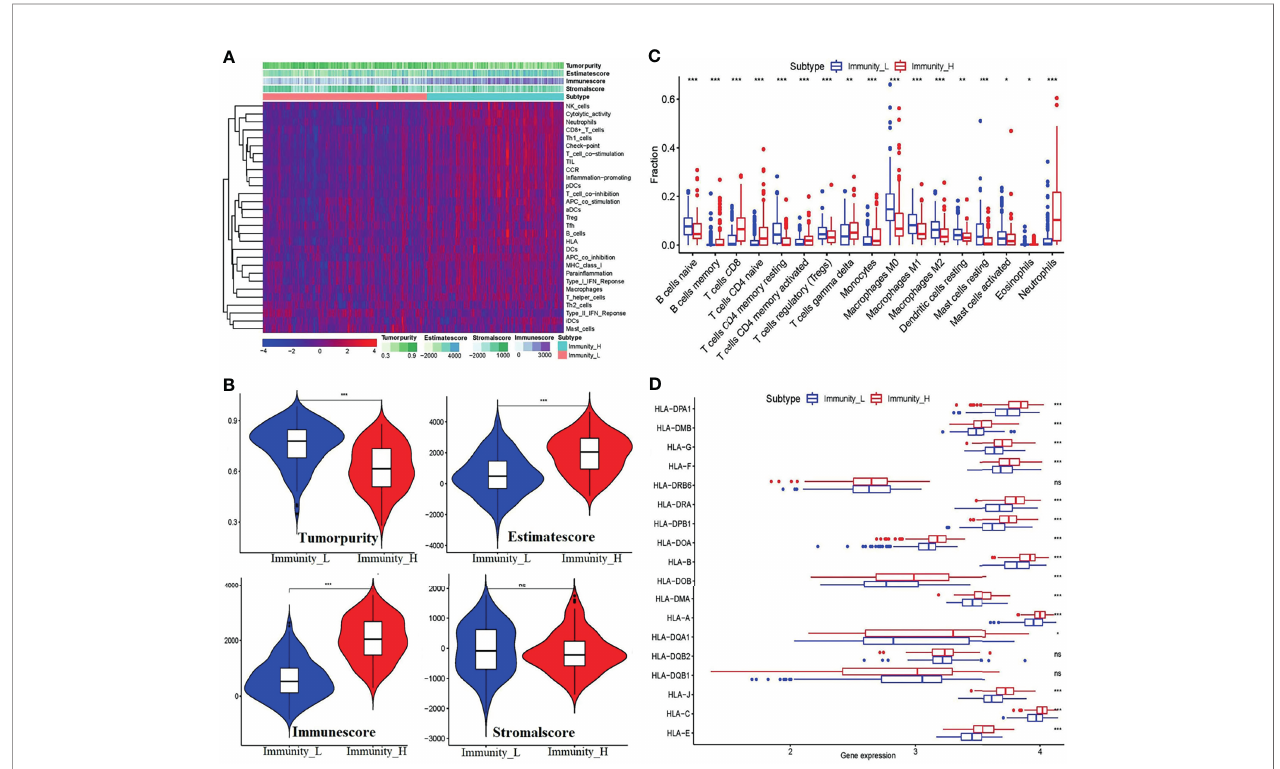
FIGURE 4 | Validation of the feasibility of the immune grouping strategy. (A) Heatmap of tumor purity, ESTIMATE score, immune score, and stromal score. (B) Violin plots showing the comparisons of the tumor purity, ESTIMATE score, immune score, and stromal score between the Immunity-L and Immunity-H subtypes. (C) The fraction of 17 kinds of immune cell in fi ltration scores between the two groupings. (D) Boxplot of HLA gene expression between the two groups. *p < 0.05, **p < 0.01, ***p < 0.001, ns, no signi fi cant